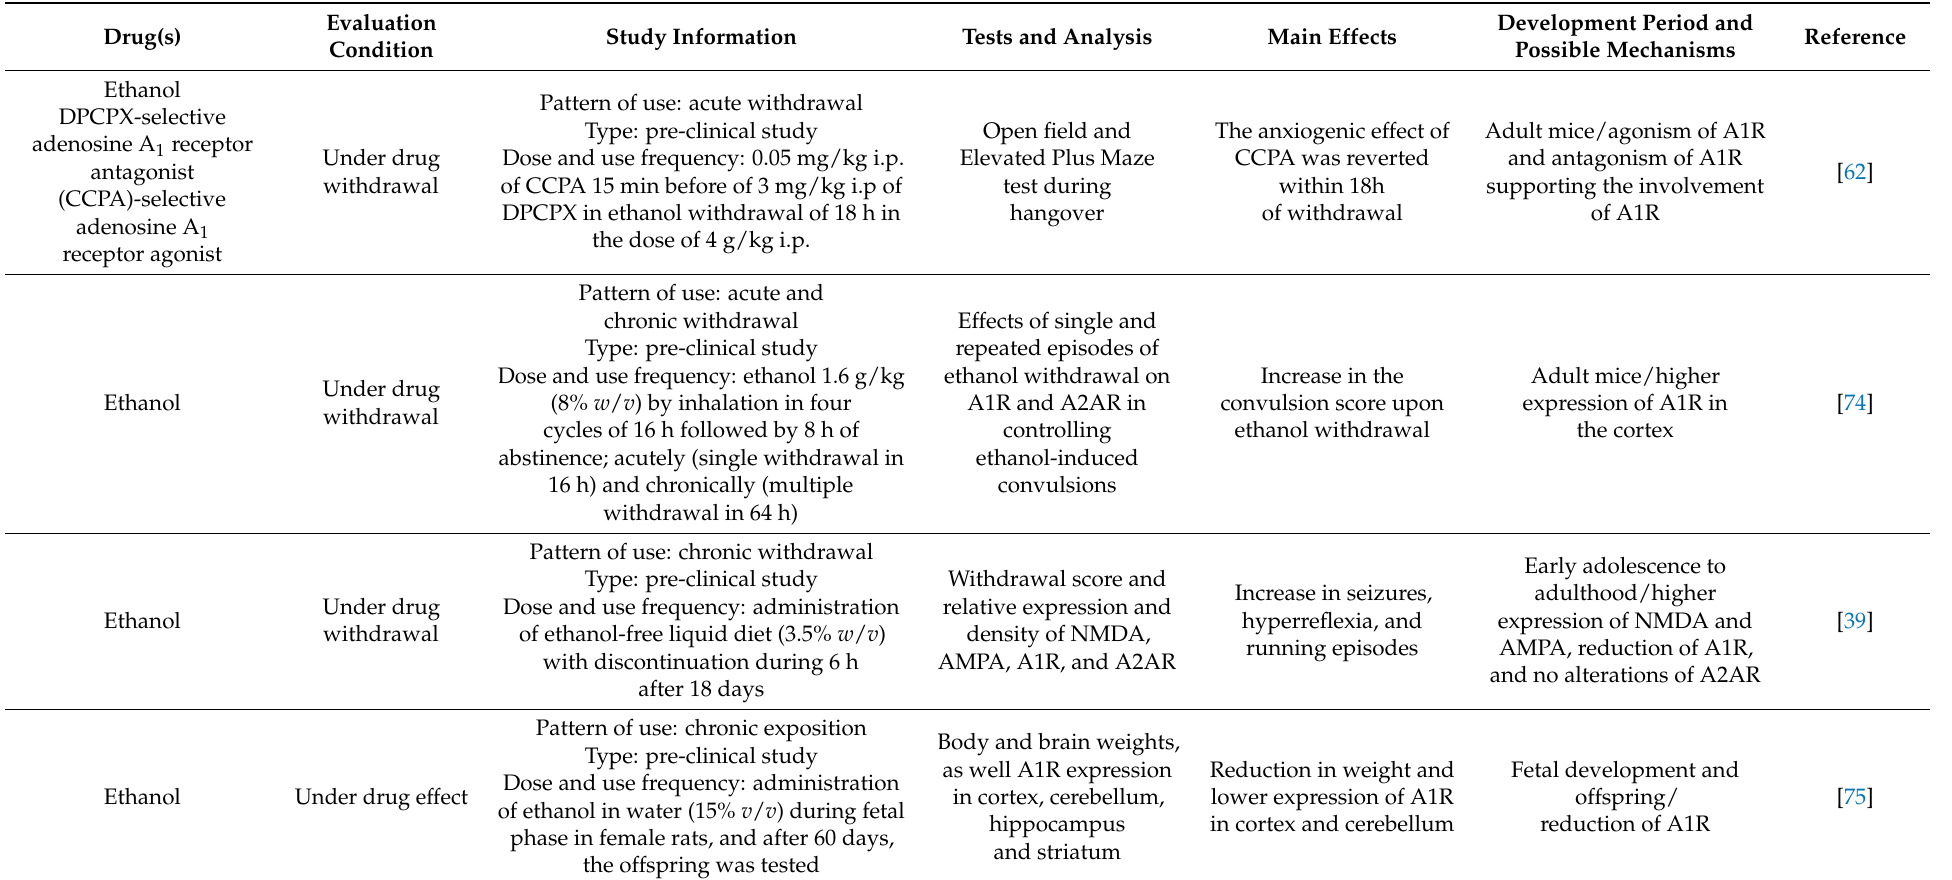
Table 1. The involvement of the adenosinergic system in behavioral and cognitive impairments induced by